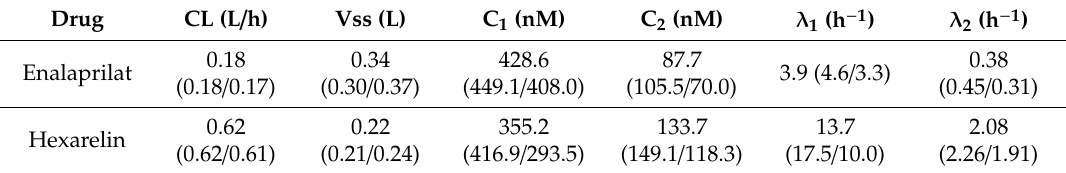
Table 2. Mean ( n = 2) pharmacokinetic data from the two-compartment analysis of the intravenous rat (340 g) plasma concentration-time profiles (Figure 2), including clearance (CL), volume of distribution at steady state (Vss), and both intercepts (C 1 and C 2 ) and slopes ( λ 1 and λ 2 ) of the first and second terms: Individual values of rat 1 and 2 in parenthesis.